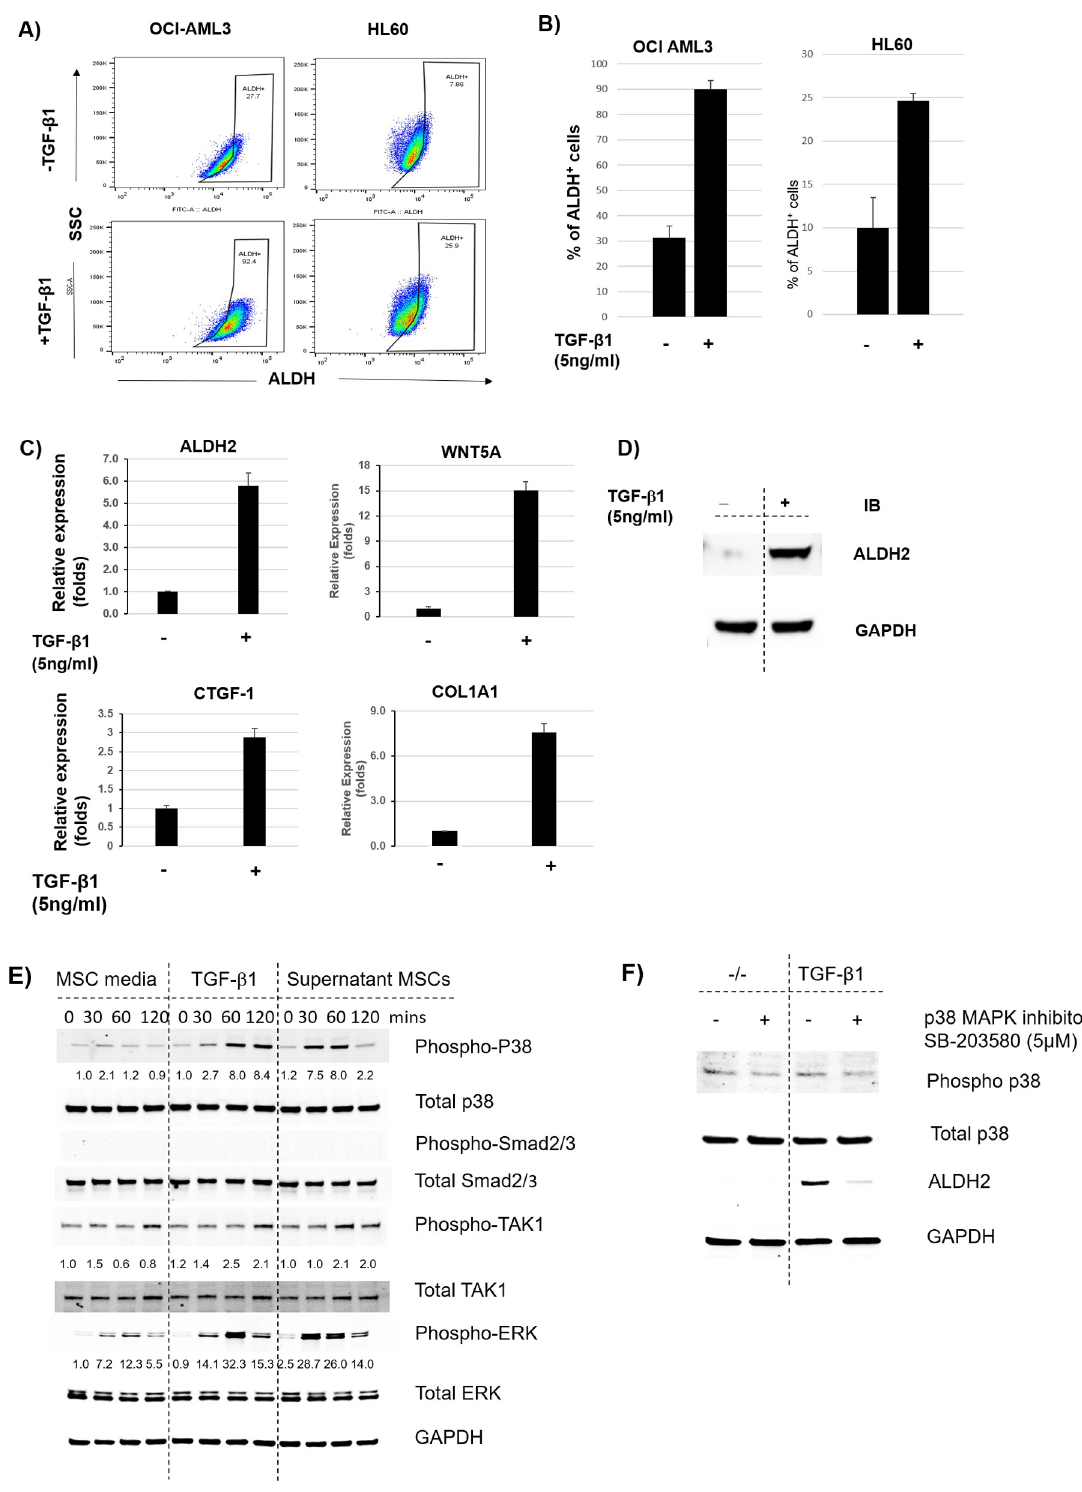
Fig 4. TGF- β 1 non-canonical pathway induces expression of ALDH2 and other downstream targets in AML cells. (A) OCI-AML3 and HL60 cells were treated with recombinant TGF- β 1 (5 ng/mL) for 3 days. Cells were stained with ALDEFLUOR 1 and ALDH activity was measured. (B) Histogram representation of the percentages of ALDH + cells in OCI-AML3 and HL60 AML cells treated with recombinant TGF- β 1 in A. (C) OCI-AML3 cells were treated with recombinant TGF- β 1 (5 ng/mL). RT-PCR was performed to analyze